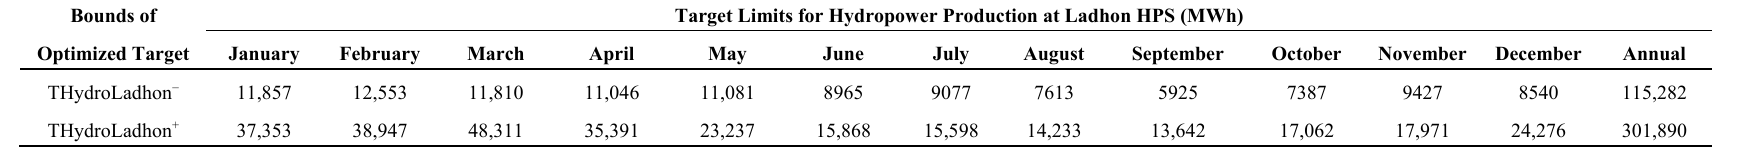
Table 1. Upper- (THydroLadhon + ) and lower- (THydroLadhon − ) bounds of optimized target for hydropower production at HPS at Ladhon. Bounds of